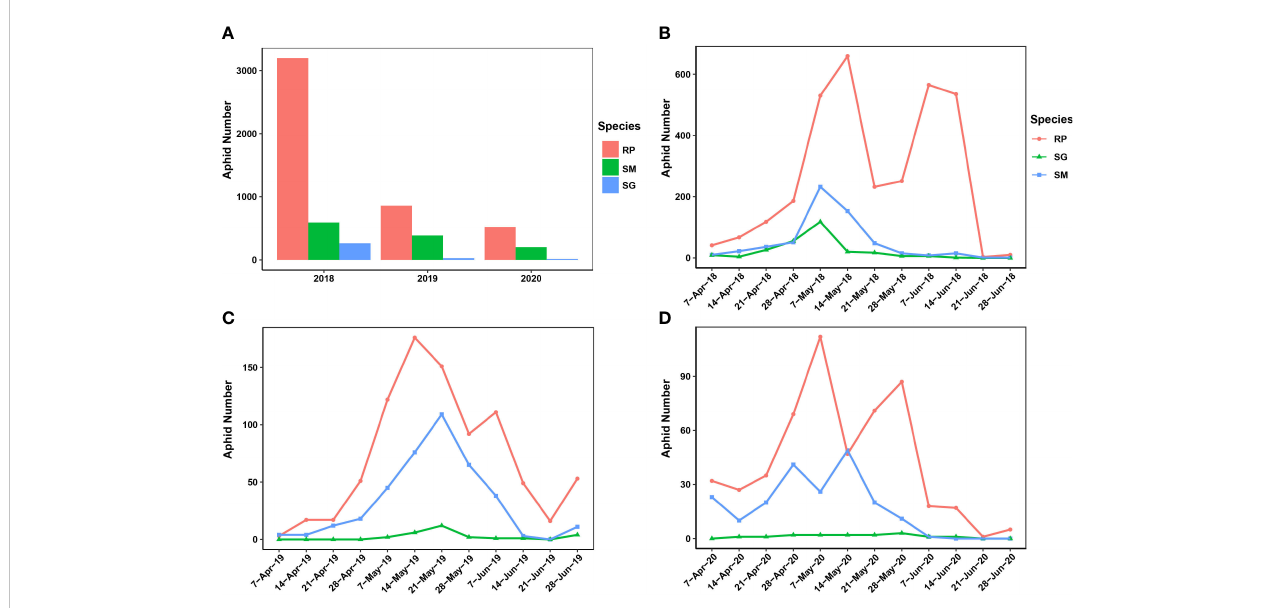
FIGURE 1 Population dynamics and migration patterns of the wheat aphids uncovered by a suction trap in Yuanyang country from 2018 to 2020. (A) The population dynamics of the three wheat aphids during 2018 – 2020. (B – D) The migration pattern of the three wheat aphids was revealed during 2018 – 2020. SM, Sitobion miscanthi ; RR, Rhopalosiphum padi ; SG, Schizaphis graminum